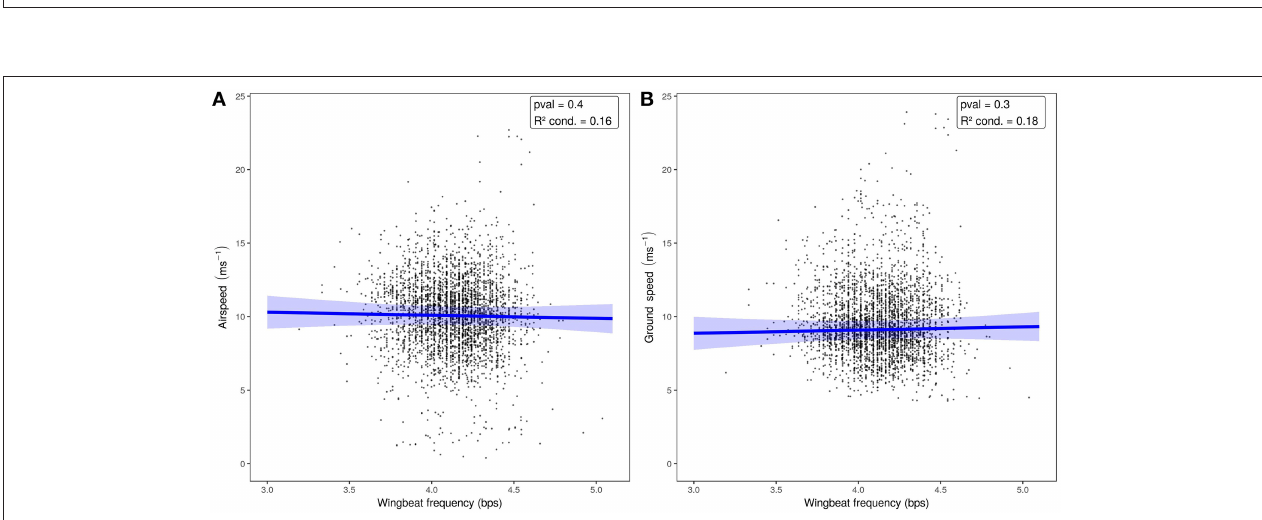
FIGURE 4 | Airspeed (A) and ground speed (B) relative to wingbeat frequency. The predictive models and 95%CI (in blue) show no relationship between wingbeat frequency and either measure of speed.